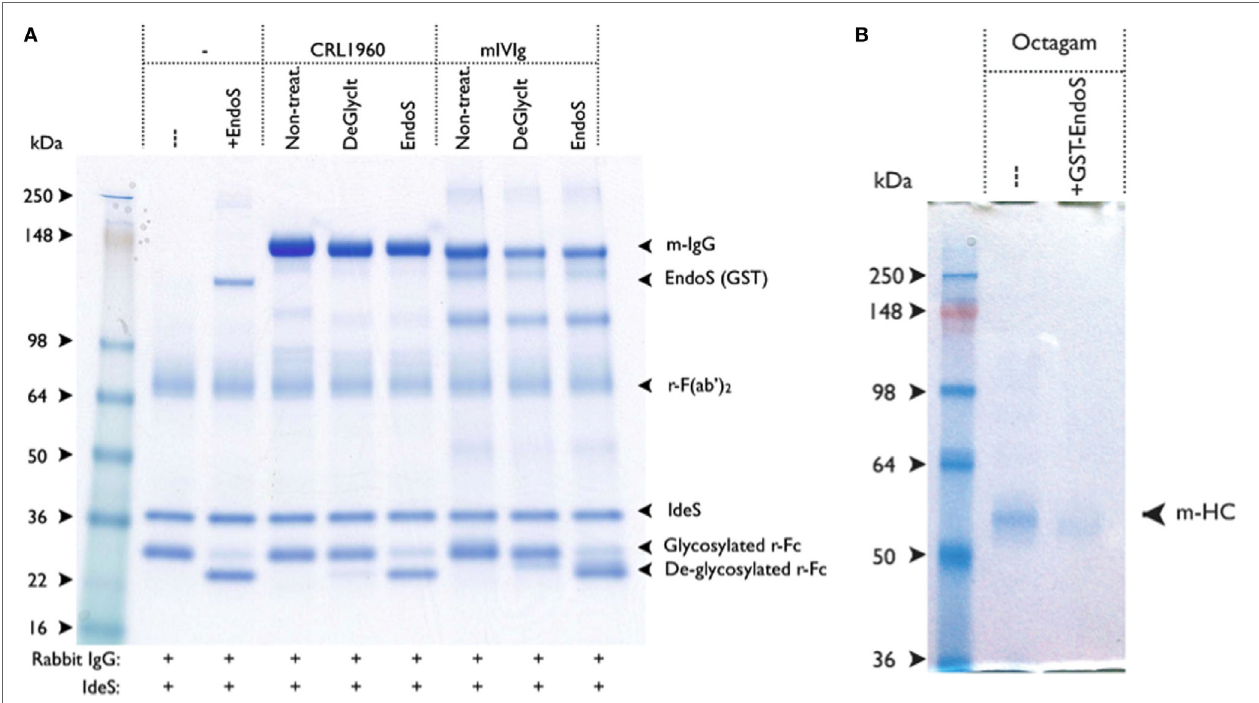
FigUre 3 | IgG treated with GST-endo- β - N -acetylglucosaminidase (EndoS) contains residual enzyme activity. (a) EndoS treated antibody preparations were tested for residual EndoS activity by using rabbit IgG cleavage assay. Rabbit IgG was used as a reporter for EndoS activity, in which ability of IdeS to efficiently cleave the heavy chain of rabbit IgG was used. After IdeS treatment, the deglycosylated rabbit Fc-fragment was distinguished from the non-deglycosylated rabbit Fc-fragment using SDS-PAGE (i.e., a 25-kDa fragment ± glycosylation). Rabbit IgG (1.7 µg) and IdeS (0.3 µg) were added to each of the sample. Molecular weight markers (lane 1); without EndoS (lane 2); with EndoS (0.5 µg, lane 3); 1.7 µg of CRL-1940 untreated (lane 4); CRL-1940 DeGlycIT treated (lane 5); CRL-1940 GST-EndoS treated (lane 6); mouse intravenous immunoglobulins (mIVIg) untreated (lane 7); mIVIg DeGlycIT treated (lane 8); mIVIg GST-EndoS treated (lane 9). m-IgG: mouse IgG, r-Fc: monomeric rabbit Fc-fragment. The gel shown was run under non-reducing condition. (B) BALB/c mice were intravenously injected with untreated control Octagam (human intravenous immunoglobulins, 1 mg) or GST-EndoS treated Octagam (1 mg). Serum was collected 18 h after injection and IgG was purified from serum using protein G sepharose. Samples were treated with IdeS to cleave remaining Octagam and the samples were analyzed on SDS-PAGE. m-HC, mouse heavy chain. IgG purified from mice injected with untreated control Octagam (lane 1) or GST-EndoS treated Octagam (lane 2) were shown. The gel shown was run under reducing